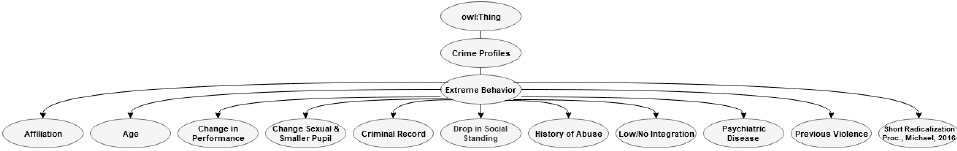
Figure 8. Subclass Extreme behavior.